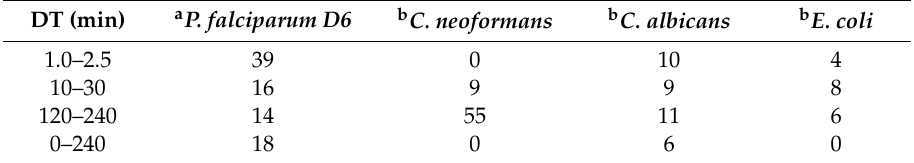
Table 4. Antimalarial and antimicrobial activities of selected fractions (percent